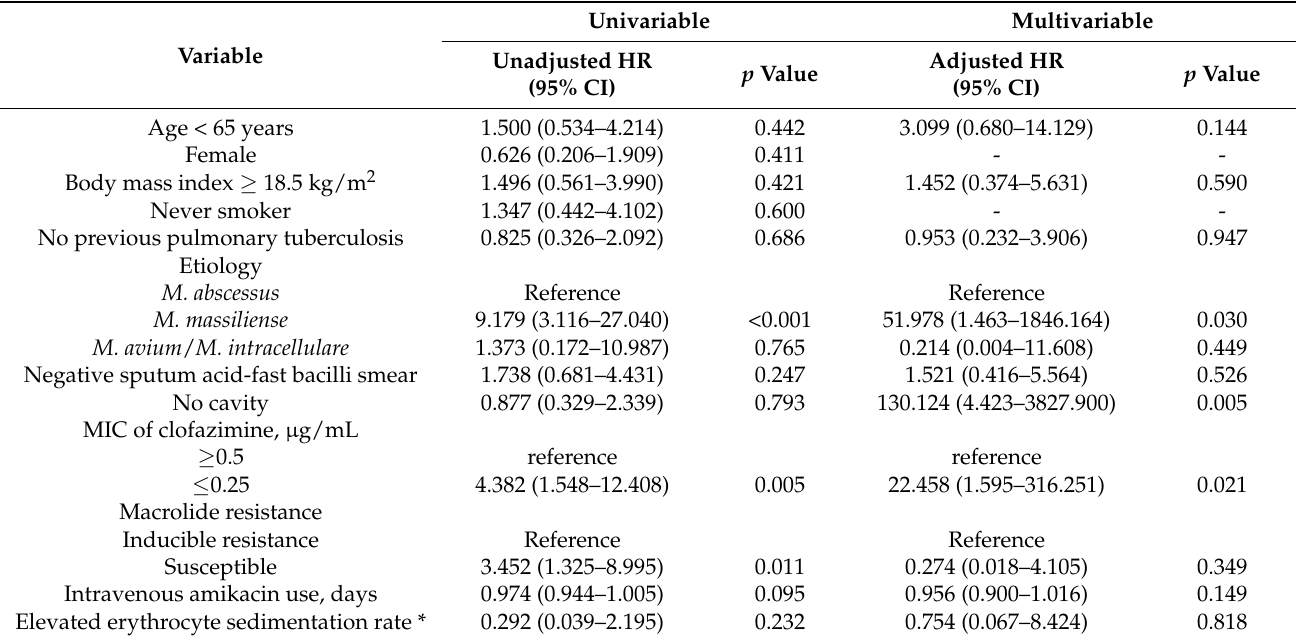
Table 5. Factors associated with culture conversion at 12 months in patients without drug-resistant isolates ( n = 38).